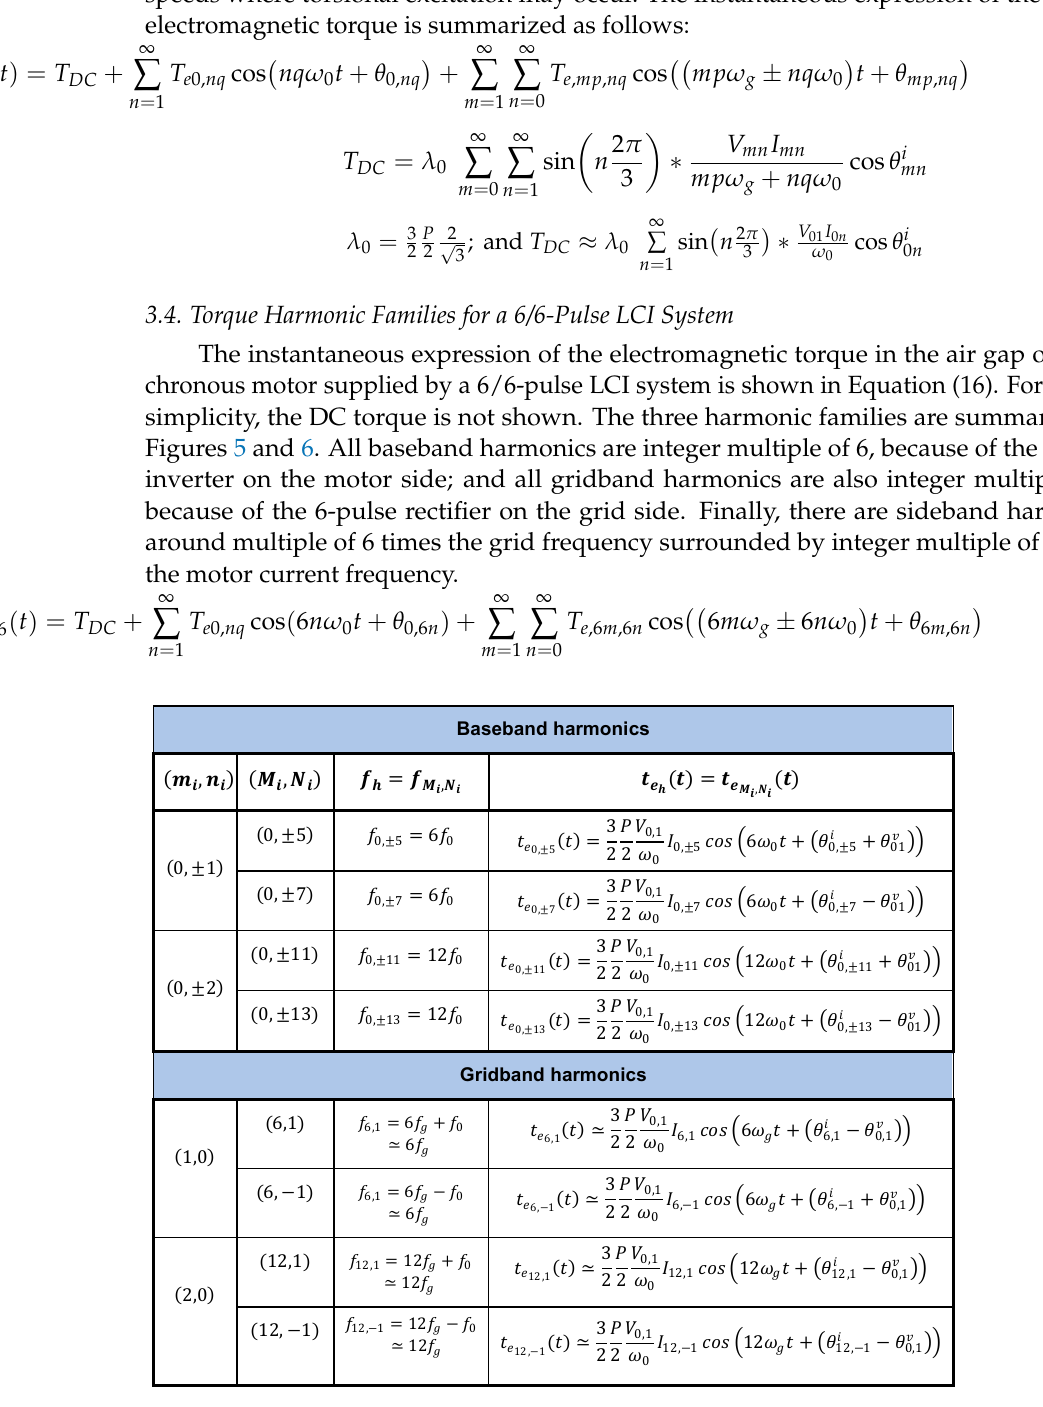
Figure 5. Harmonic families in a 6/6-pulse LCI system: baseband and gridband families.